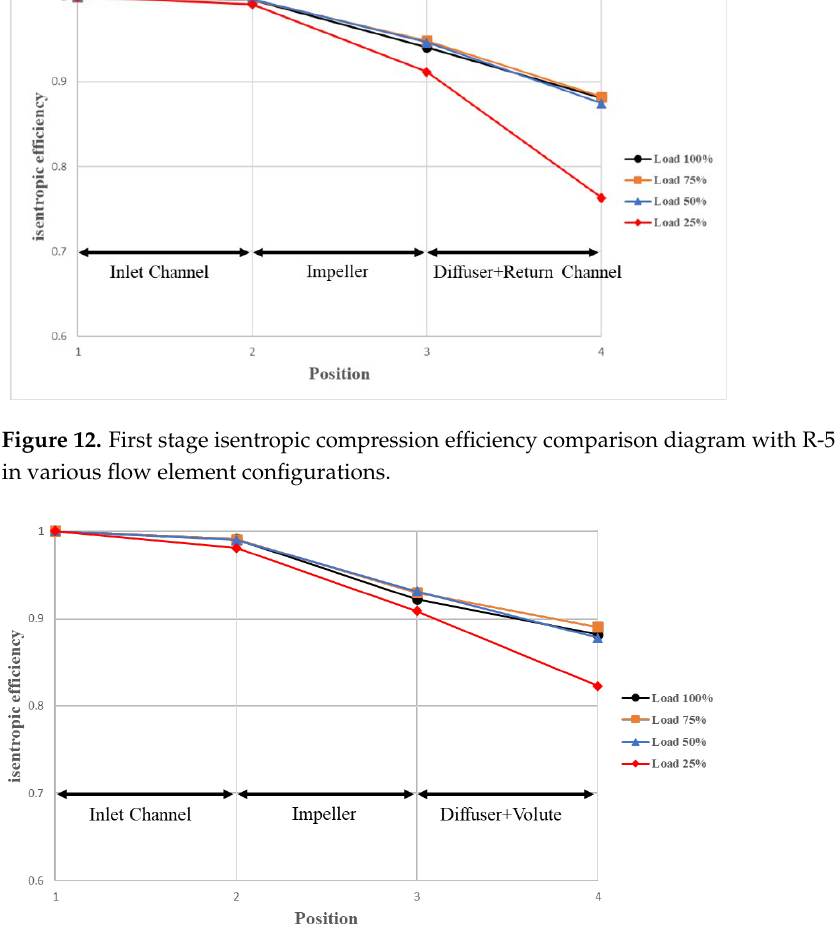
Figure 14. Schematic diagram of first stage compression meridian plane with R-513A refrigerant.